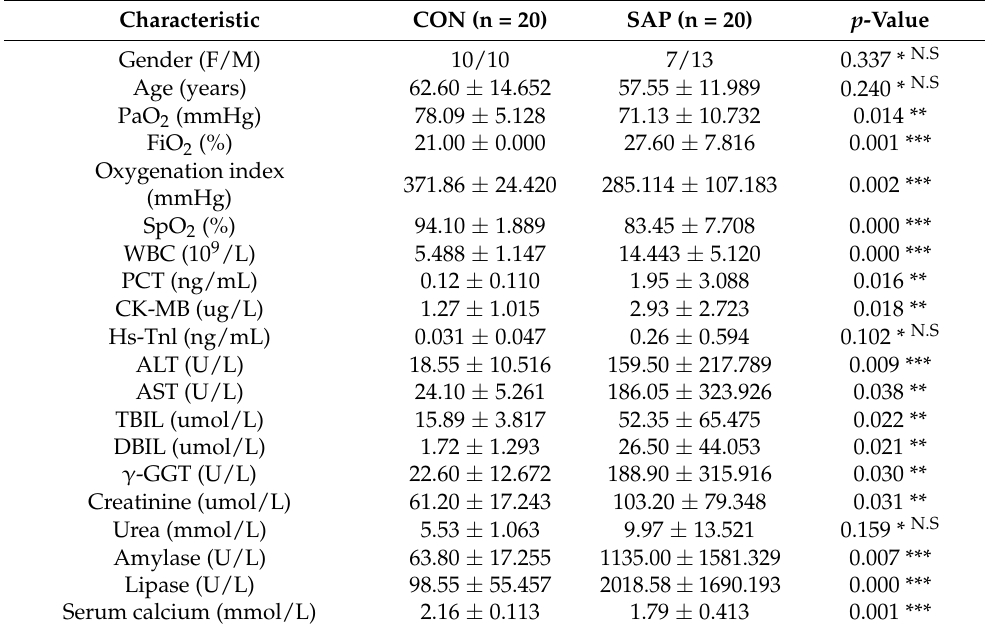
Table 1. Clinical characteristics of the SAP and CON groups.